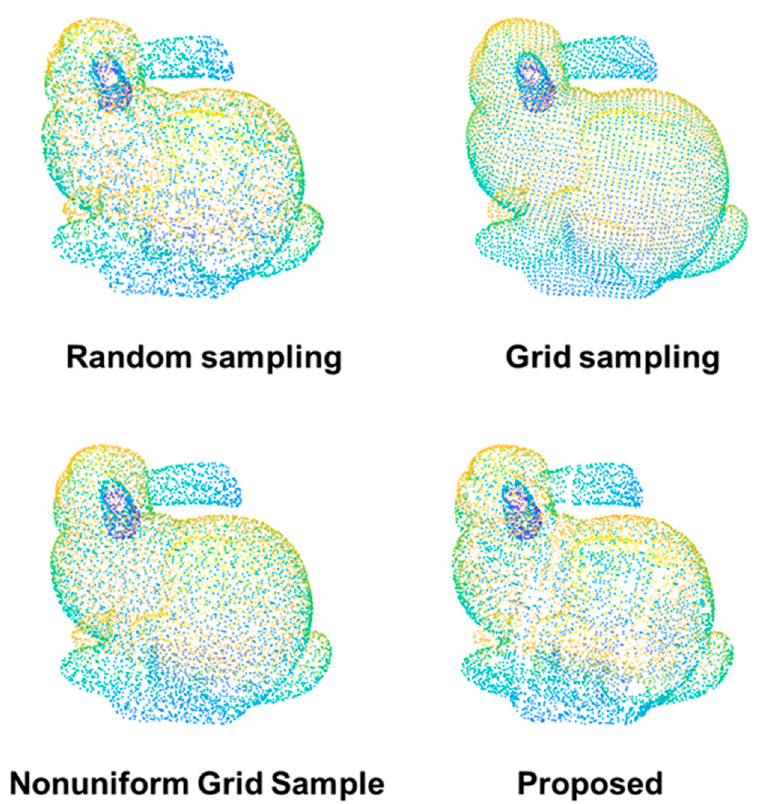
Figure 3. Point cloud data resampling comparison results of di ff erent methods.